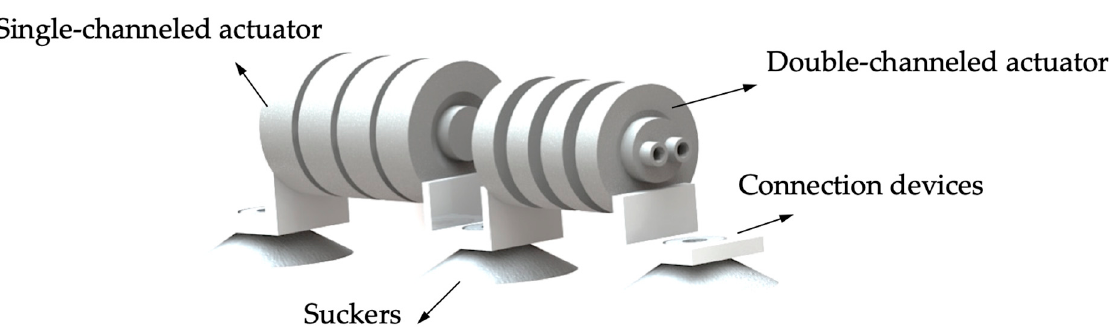
Figure 1. The overall design of the soft crawling robot.